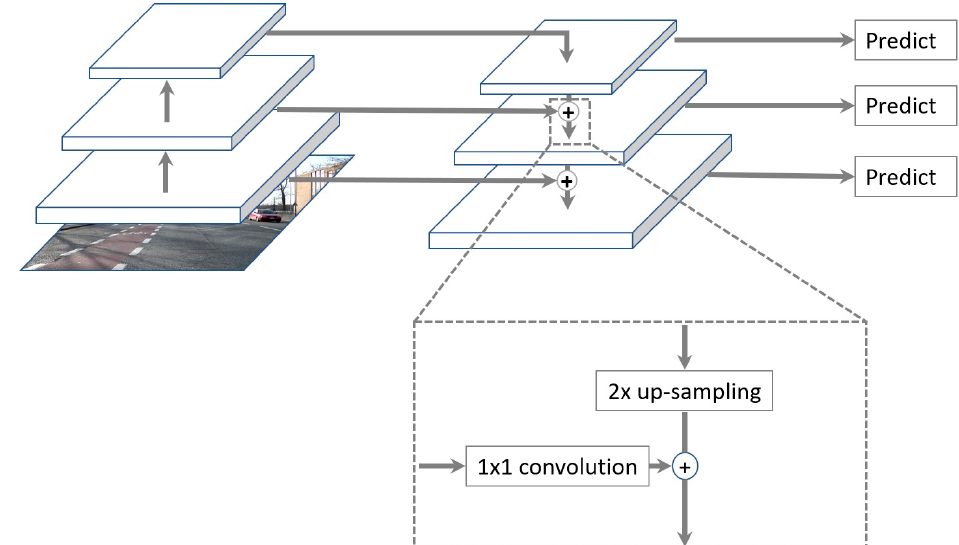
Figure 6. Lateral connections between the ResNet backbone and FPN, and top-down pathway merged by addition .